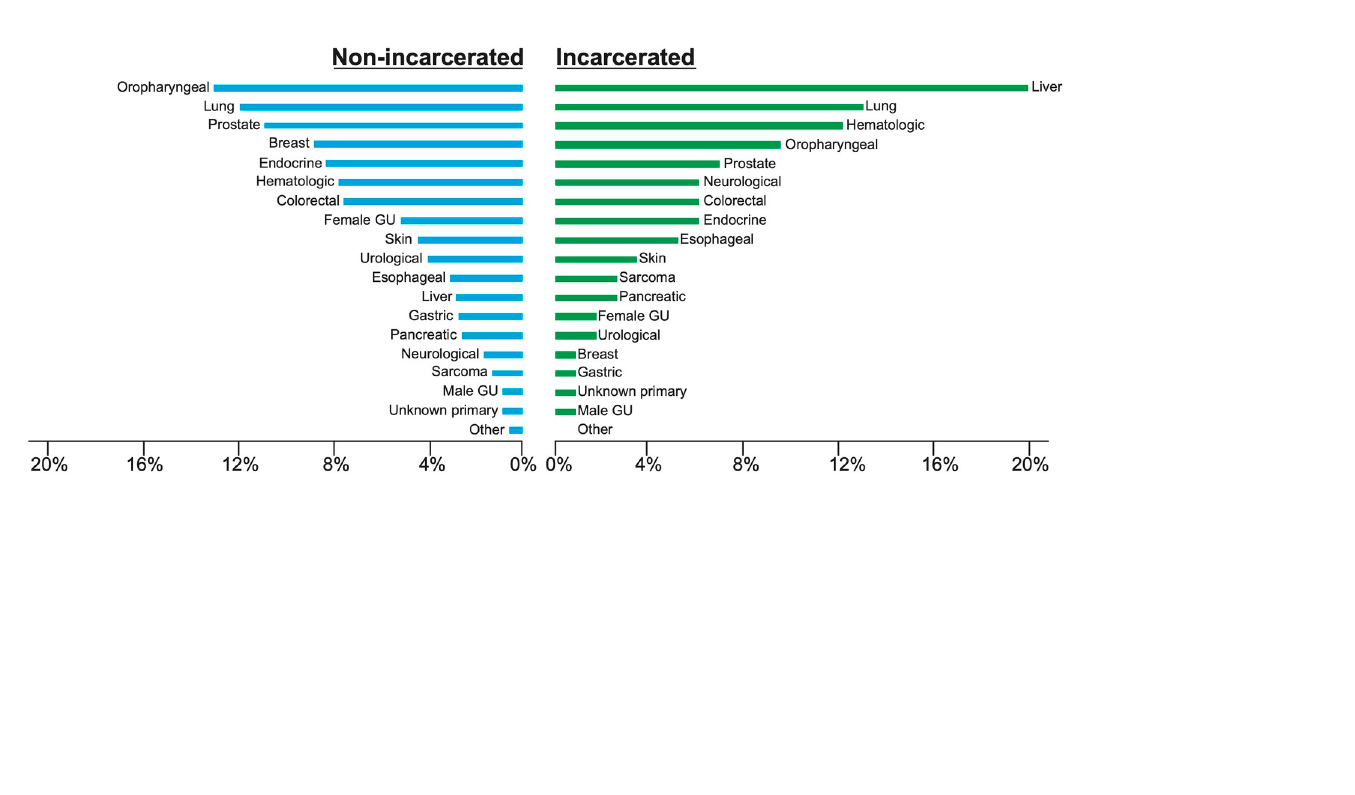
Fig 1. Incidence of different cancer subtypes in incarcerated patients and non-incarcerated patients. Bars represent the percentage of each cancer subtype in IP and NIP cases. Hepatobiliary (31.1%), Bronchopulmonary (20.3%) and oropharyngeal (14.9%) were most common in IP, while oropharyngeal (24.9%), bronchopulmonary (22.3%) and prostate (21.0%) were most common in